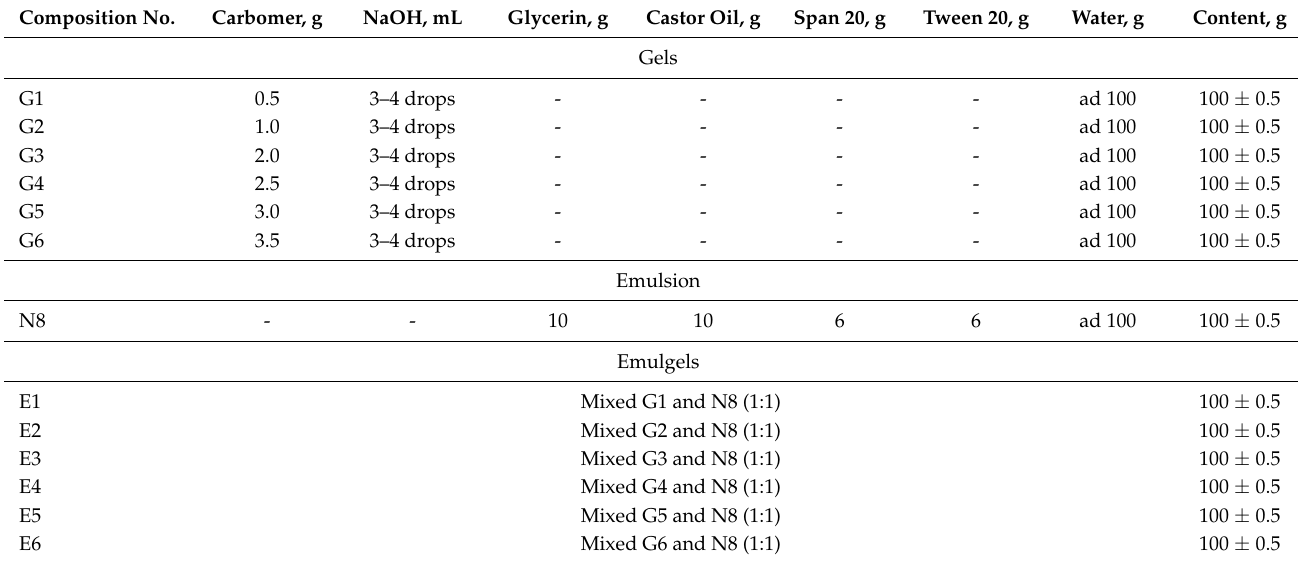
Table 1. Composition of the gels, emulsions and